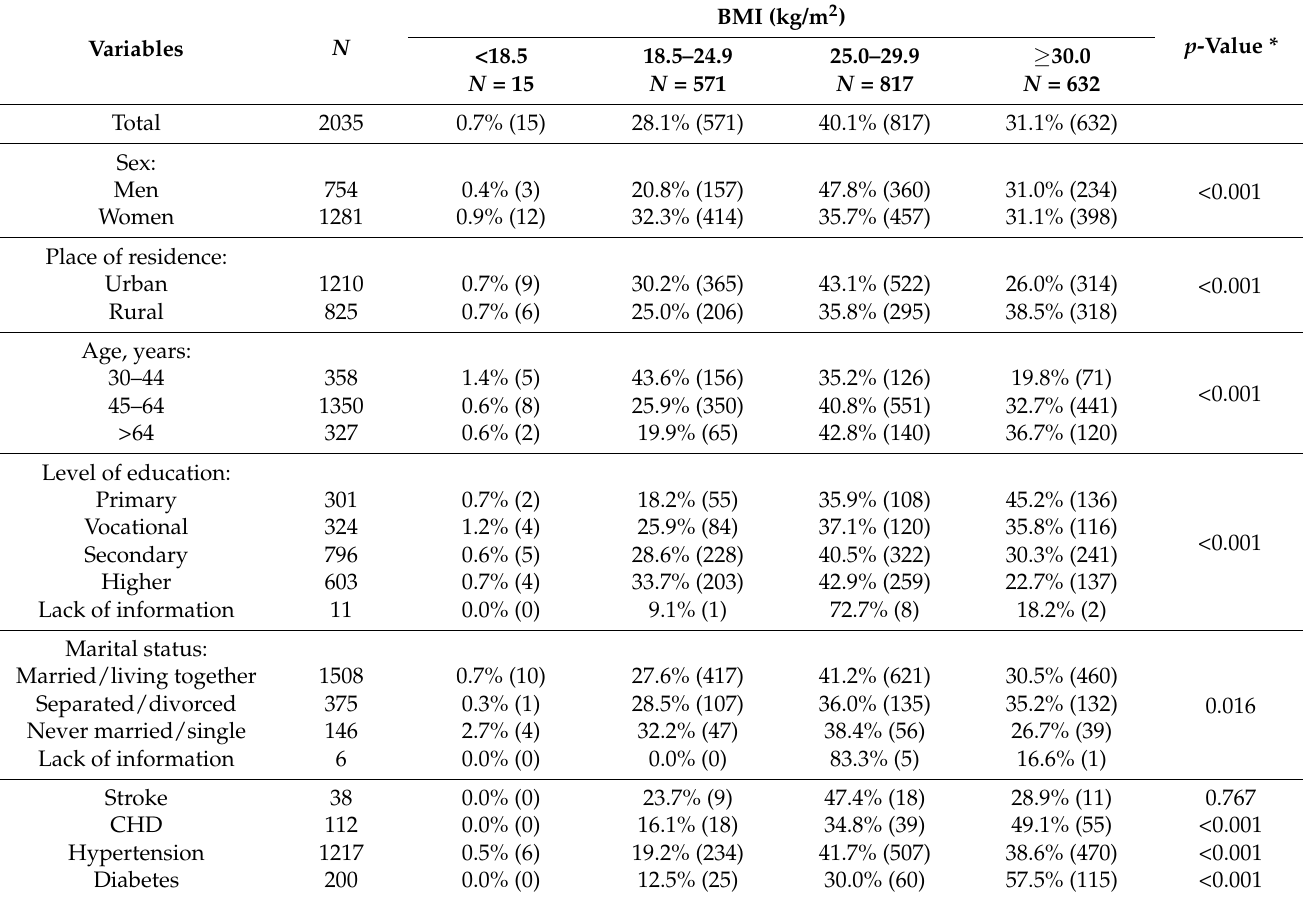
Table 1. A baseline characteristics of the study population in the view of body mass index